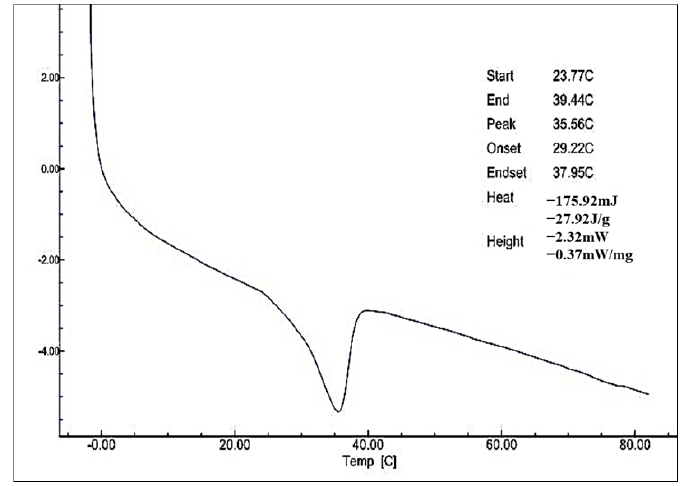
Figure 5. DSC Thermogram of monolaurin which was isolated from product glycerolysis palm kernel olein-stearin blend.